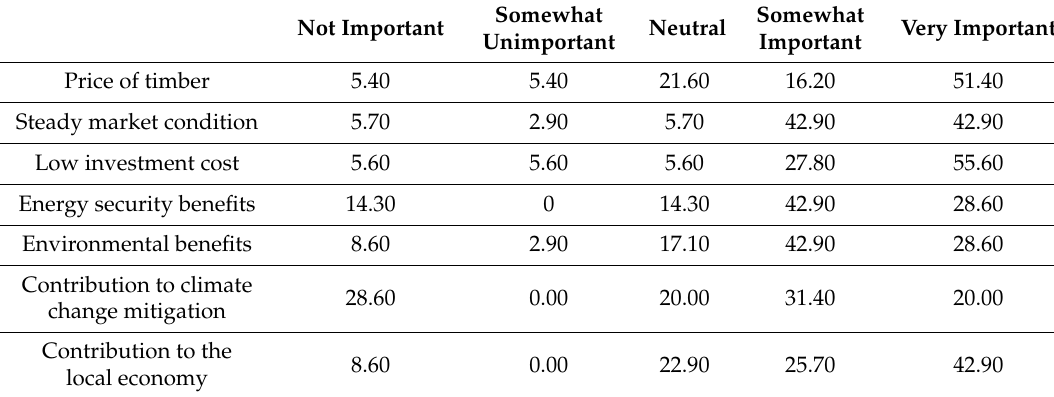
Table 1. Survey results on factors influencing landowners’ decision to produce and harvest bioenergy crops (in